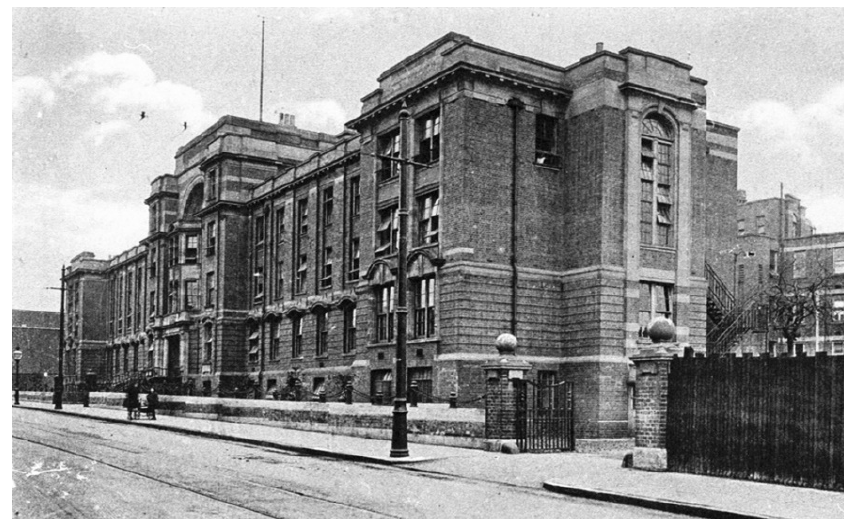
Figure 2. Birmingham Children’s Hospital circa 1950s.